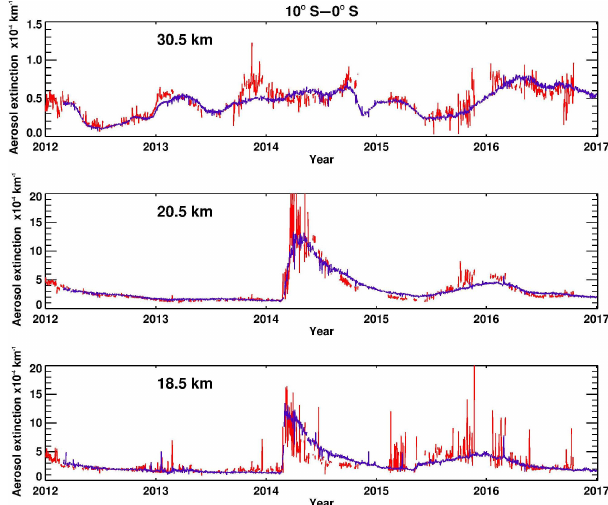
Figure 24. OMPS LP V1 (blue line) and OSIRIS V5.07 (red line) retrieved aerosol extinction daily zonal means at selected al- titudes from 2012 to 2016, at latitudes between 10 and 0 ◦ S. The OSIRIS data set reports aerosol extinction at 750nm, so the OMPS aerosol extinction was converted from 674 to 750nm by using the Ångström coefficient consistent with the aerosol size distribution assumed in the OMPS LP V1